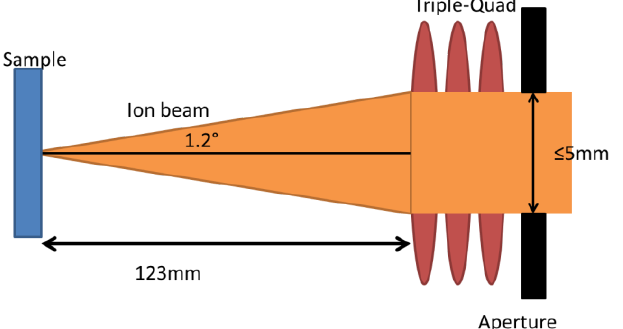
Figure 6. Sketch of the focusing setup. The ion beam originates from the right side. The object aperture defines its size. Three quadrupole magnets focus the beam onto the movable sample.